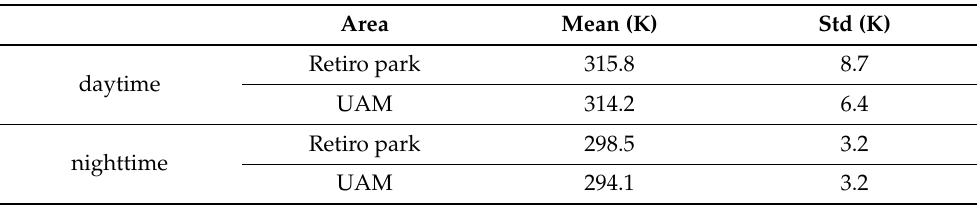
Figure 9. LST in K retrieved from the 1MMD-7-band TES of [59] over the Retiro park daytime ( top left ) and nighttime ( bottom left ) and over the UAM area daytime ( top right ) and nighttime ( bottom right ). Table 4. First-order statistics of the 1MMD-7-band TES over the Retiro park and the UAM areas for the 4 of July